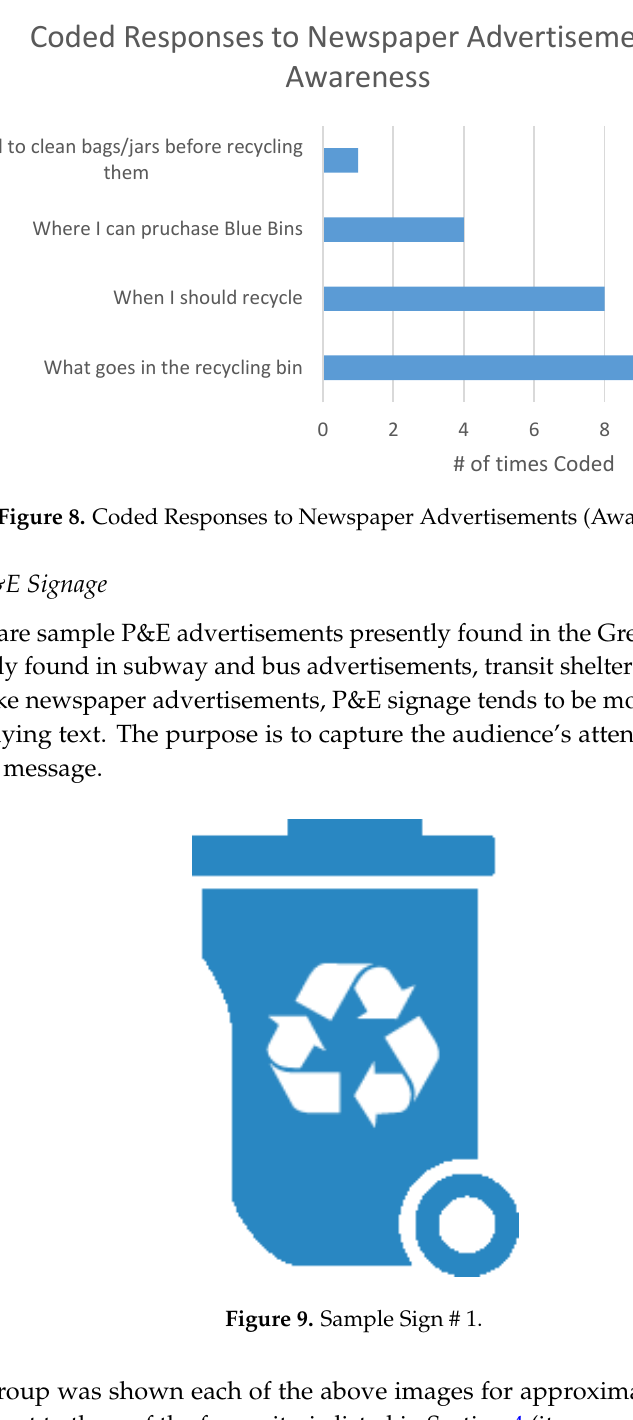
Figure 10. Sample Sign #2